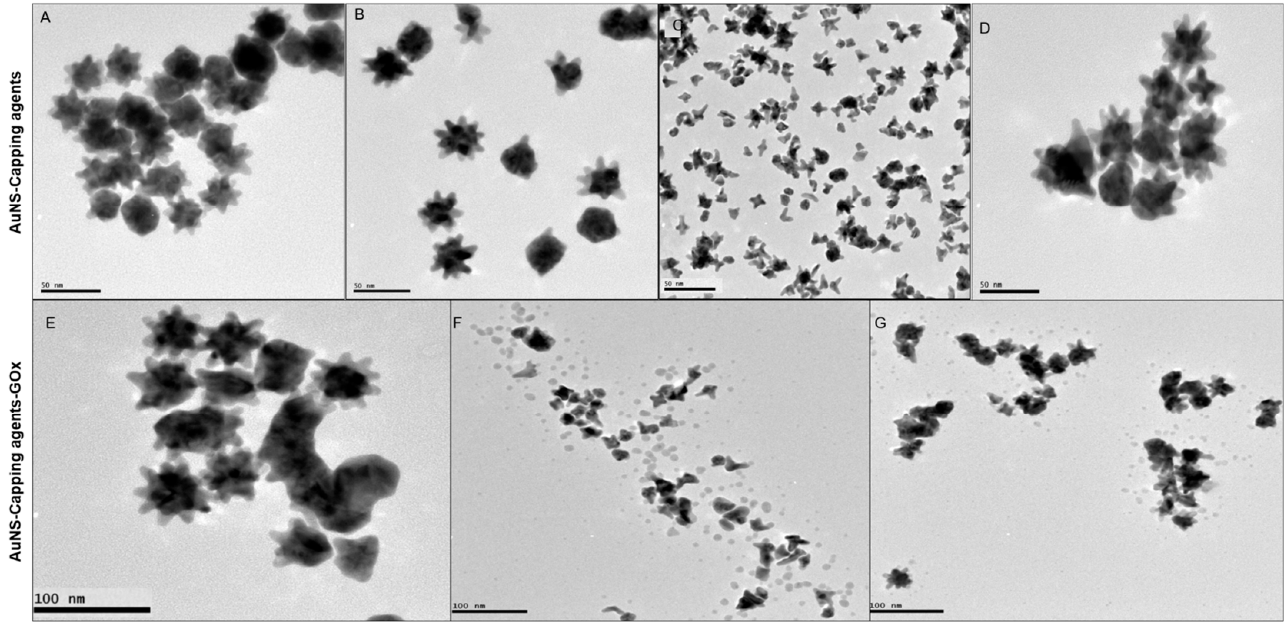
Figure 2. Representative HR-TEM images of the gold nanostar morphologies: ( A ) AuNS; ( B ) AuNS-PVP; ( C ) AuNS-PEO; ( D ) AuNS-PEG; ( E ) AuNS-PVP-GOx; ( F ) AuNS-PEO-GOx; and ( G ) AuNS-PEG-GOx.